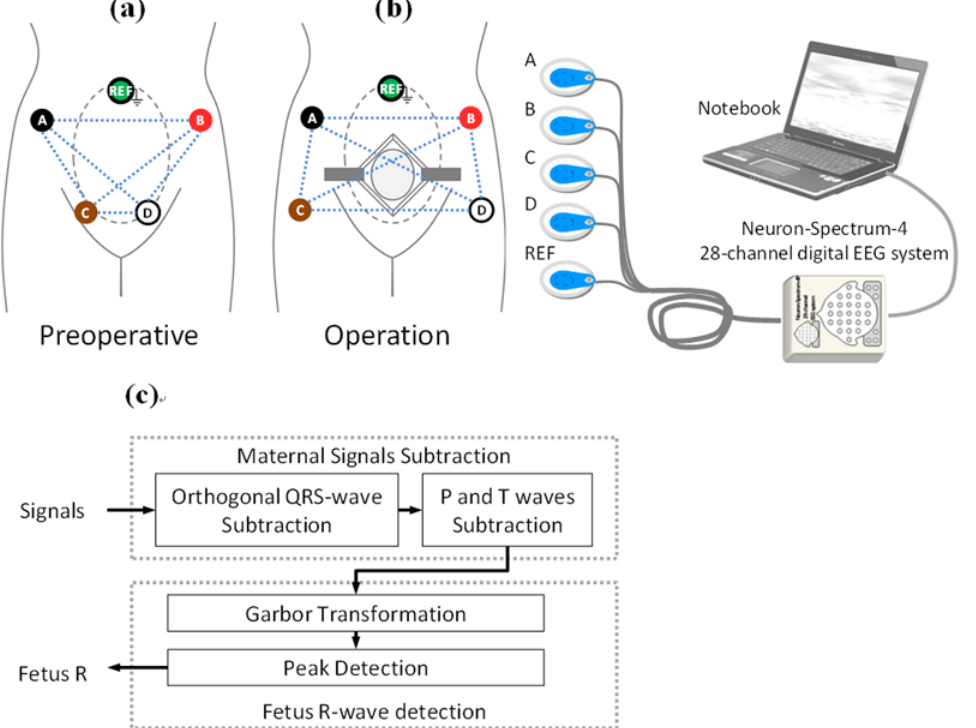
Fig 1. Five abdomen electrodes (four electrodes for signal collecting and one for reference) were placed in different ways for two scenarios. (a) before and (b) during the surgical operations. (c) The work-flow chart of our proposed algorithm. We use four electrodes (marked as A, B, C, and D) for signal acquisition and one (marked as G) for common system reference electrode. Since an voltage signal usually represents a difference between the voltages at two electrodes in EEG measurements, the number of voltage signals in our study would be six (two out of four leads: V AB , V AC , V AD , V BC , V BD , V CD ). Noted that the fetal positions are changing during the laboring process, it is our experience that we can ensure the detection of high quality signals (at least one of the voltage signals) by using the applied experimental